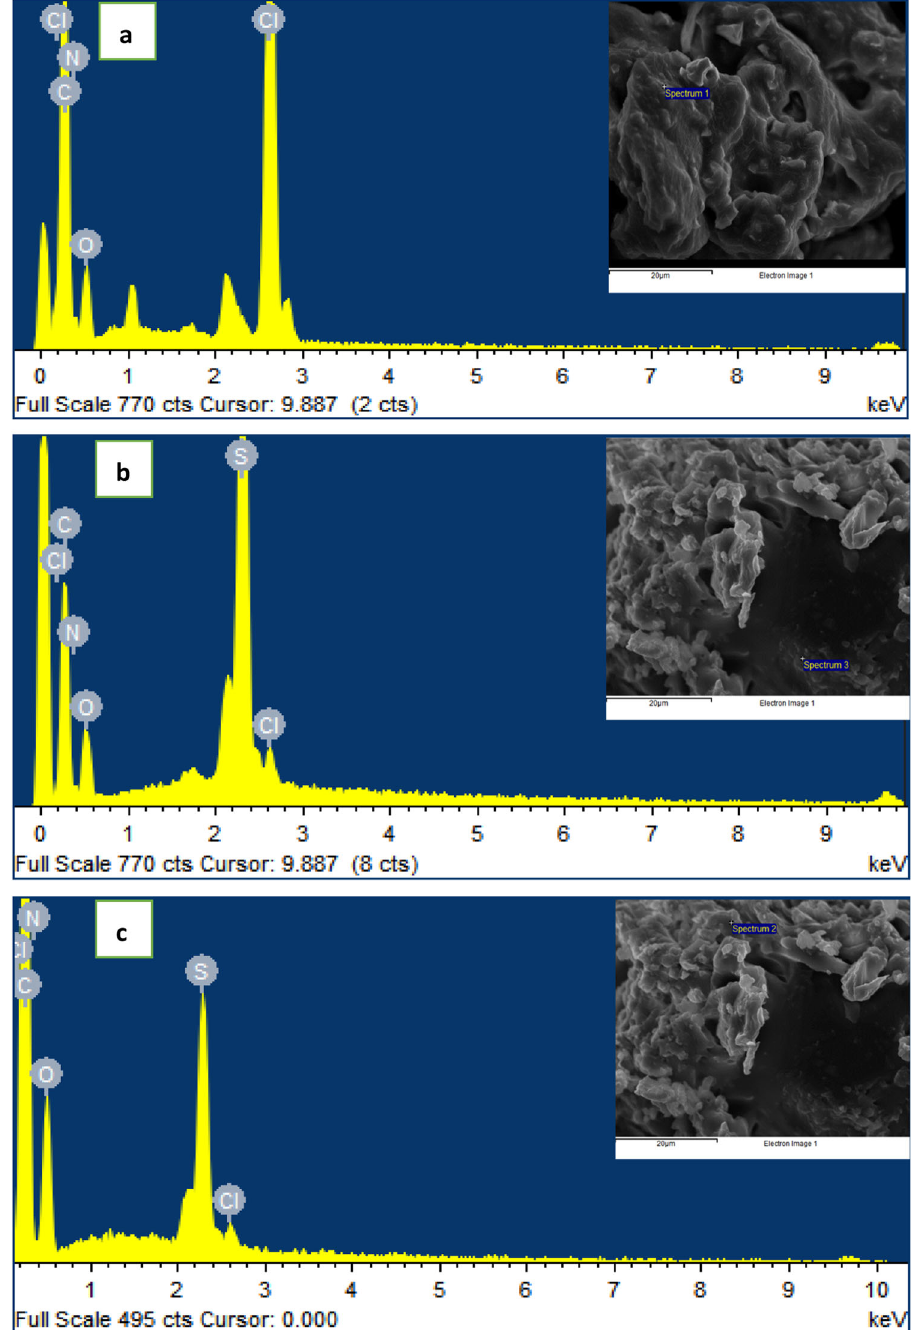
Fig. 5 EDS energy spectroscopy analysis of SGPQG/SGPQ before and after treating lignin. a EDS energy spectroscopy analysis of SGPQG/ SGPQ before treating lignin. b EDS energy spectroscopy analysis of inner SGPQG/SGPQ after treating lignin. c EDS energy spectroscopy analysis of SGPQG/SGPQ surface after treating